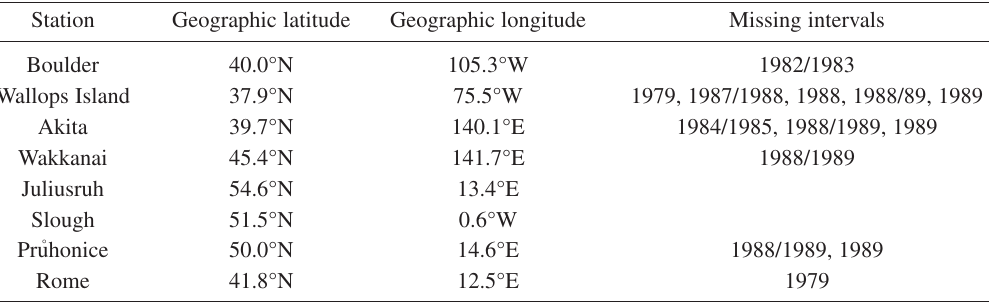
Table I. Co-ordinates of ionospheric stations and missing intervals from period 1979-1989. Station Geographic latitude Geographic longitude Missing intervals Boulder Wallops Island